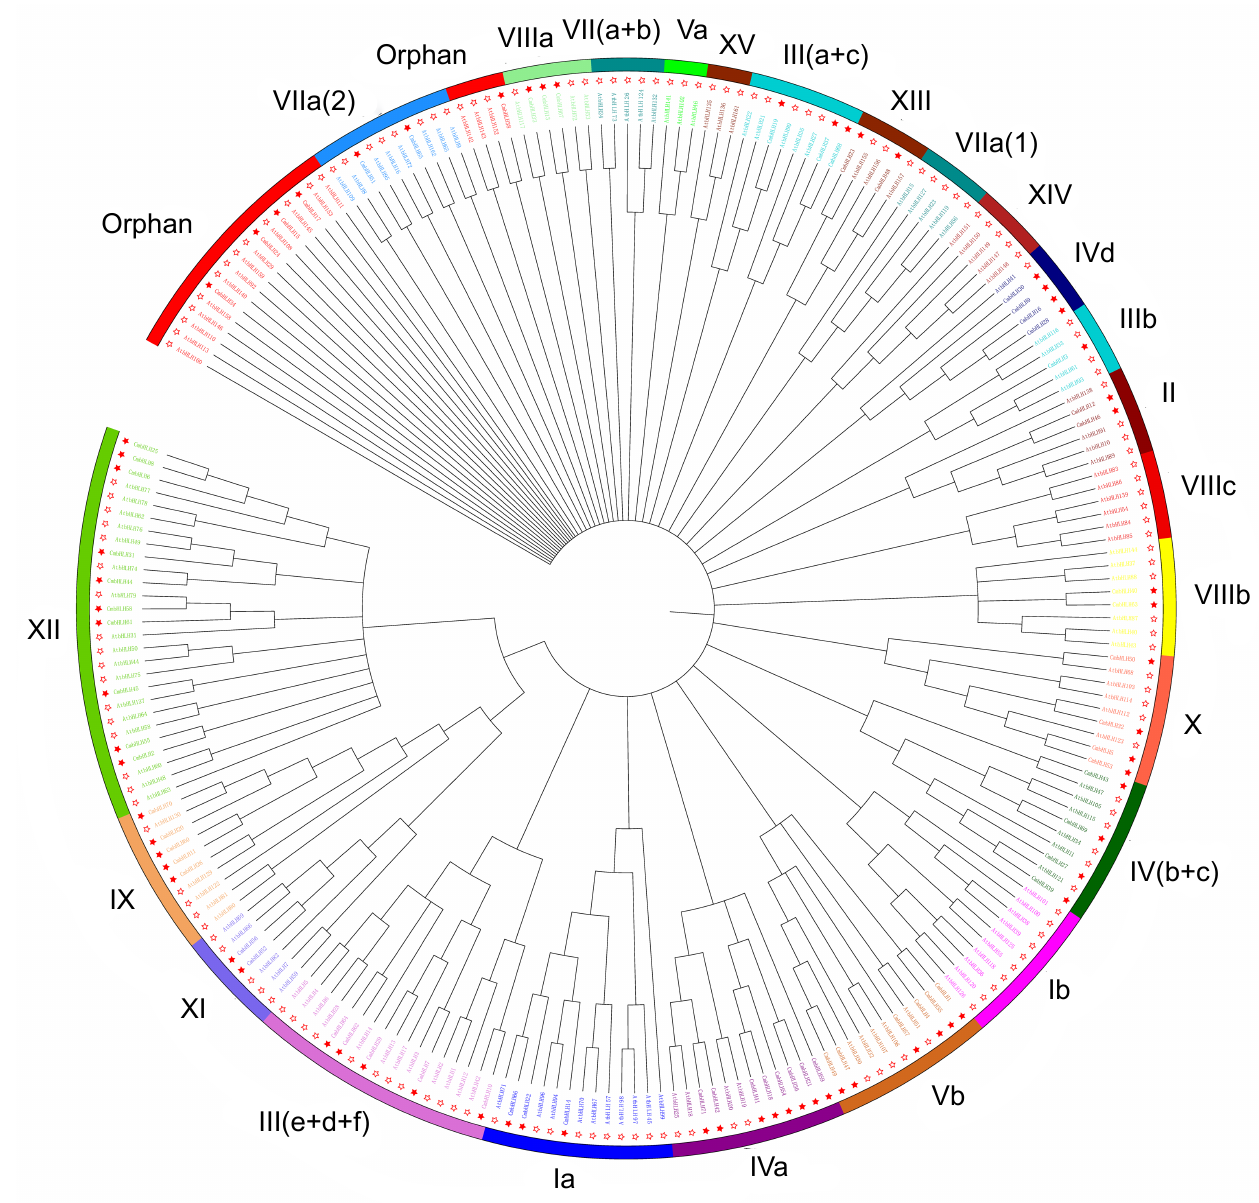
Figure 1. Phylogenetic relationship of the bHLH TF family among Arabidopsis and Chrysanthemum . Different colored arcs are used to distinguish different groups or subgroups. The hollow star and red solid star represent Arabidopsis and Chrysanthemum ,